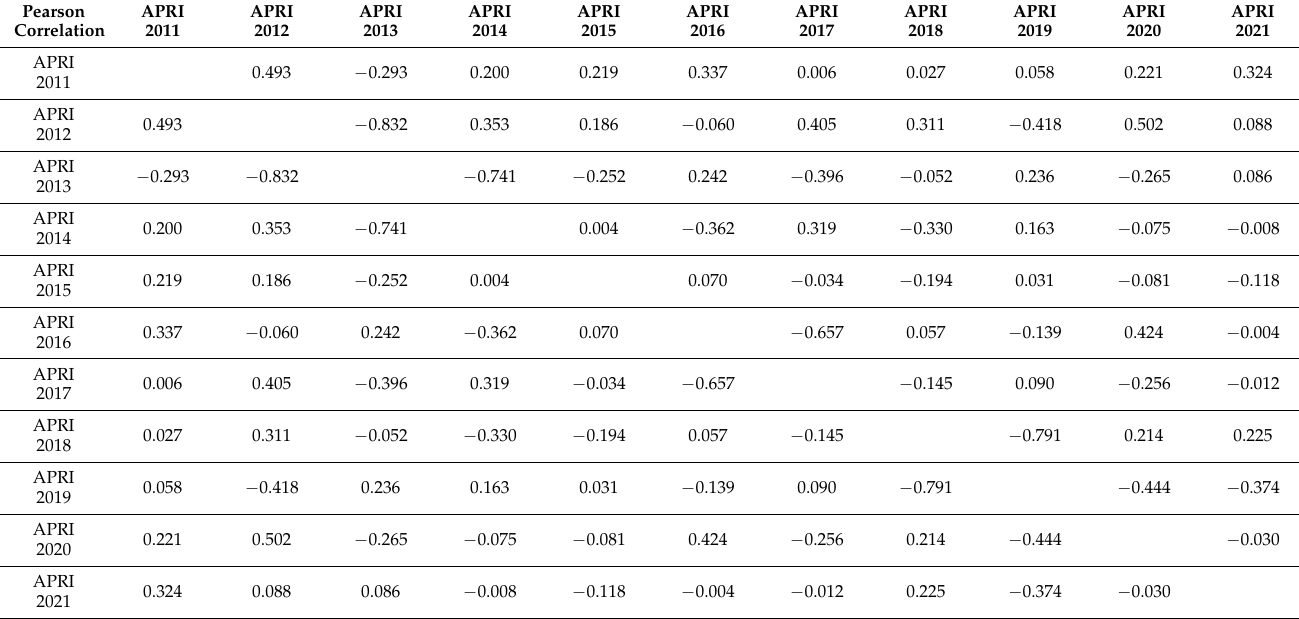
Table A2. Pearson correlation rates in dynamics for selling prices of crop products indicator. Pearson